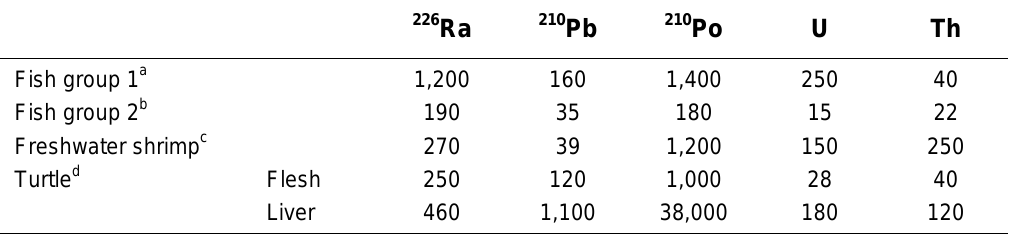
CRs (L kg –1 ) for Radionuclides in Several Aquatic Fauna, Determined from Samples Collected in the ARR 226